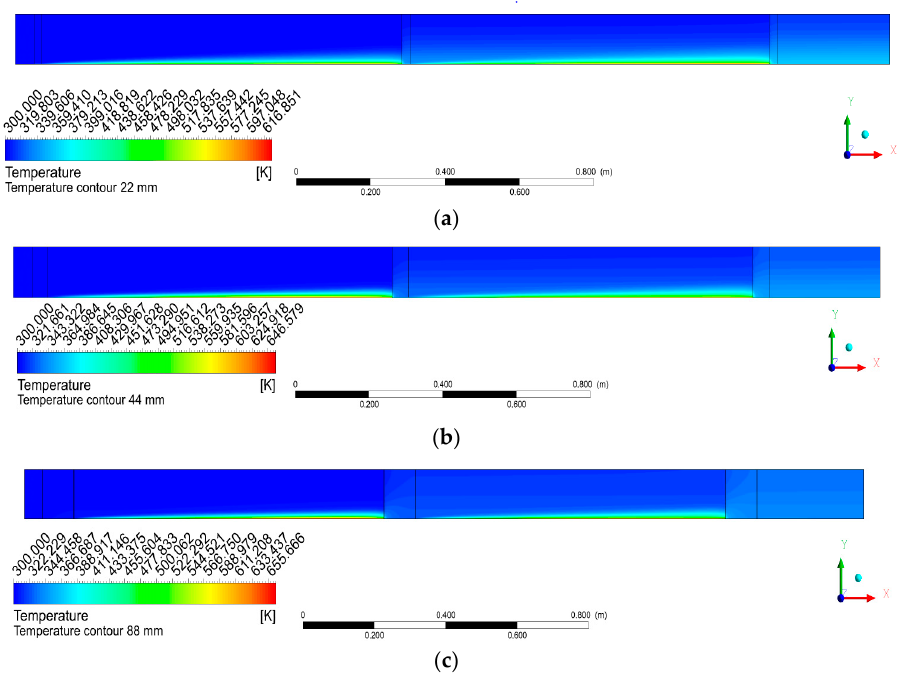
Figure 7. Contour of temperature for 30 PPI 0.92 porosity copper metal foam at 0.3779 velocity of ( a ) 22 mm, ( b ) 44 mm and ( c ) 88 mm thick metal foam.